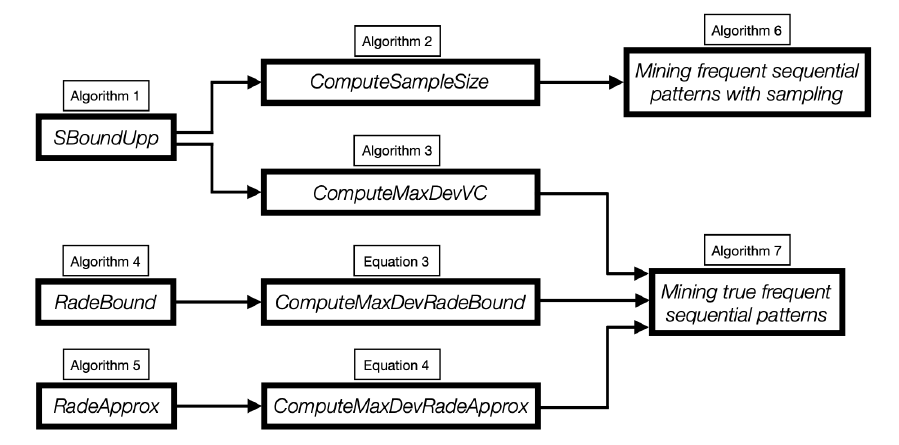
Figure 2. Block diagram representing the relations between our